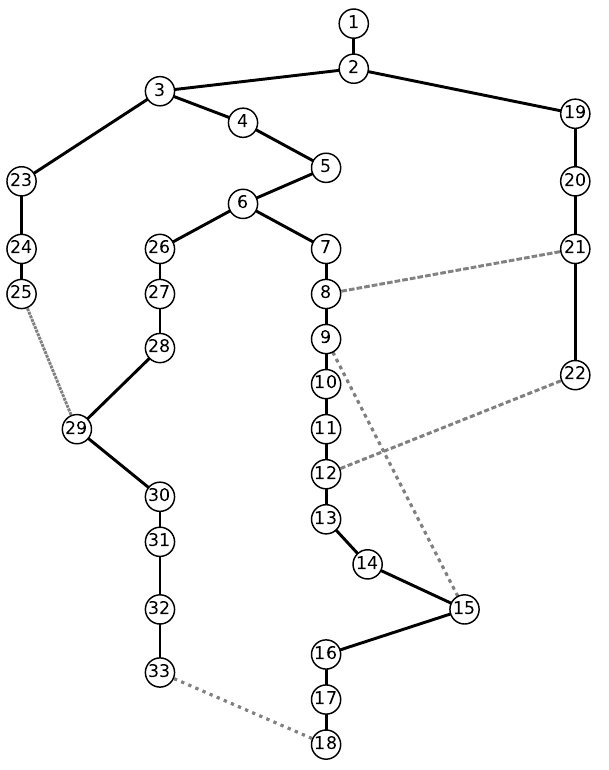
Figure 1. Graph representation of the Case 33